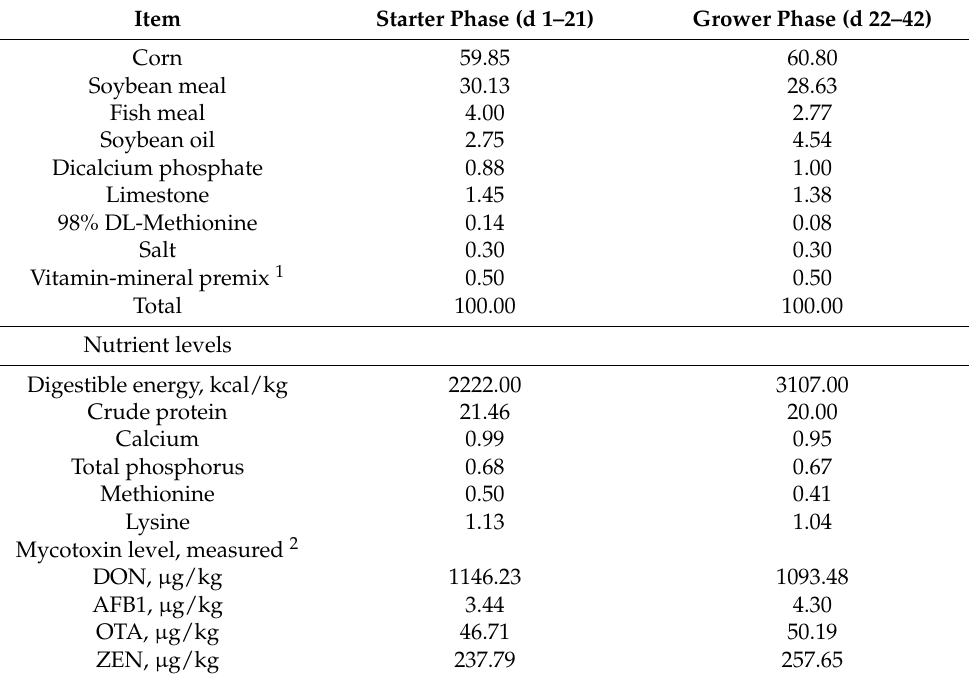
Table 1. Composition and nutrient levels of basal diets (%, dry matter